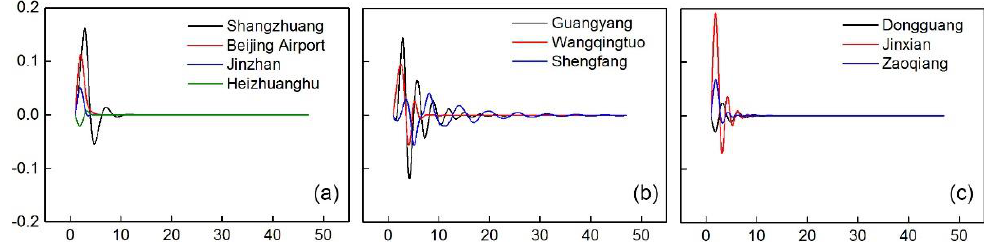
Figure 15. Orthogonal impulse response from groundwater level change to subsidence in subsidence features of ( a ) Shangzhuang Beijing Airport, Jinzhan and Heizhuanghu, ( b ) Guangyang, Wangqingtuo and Shengfang, ( c ) Dongguang, Jingxian and Zaoqiang. The horizontal axis represents the lag order of the impact (month), and the vertical axis represents the response degree.